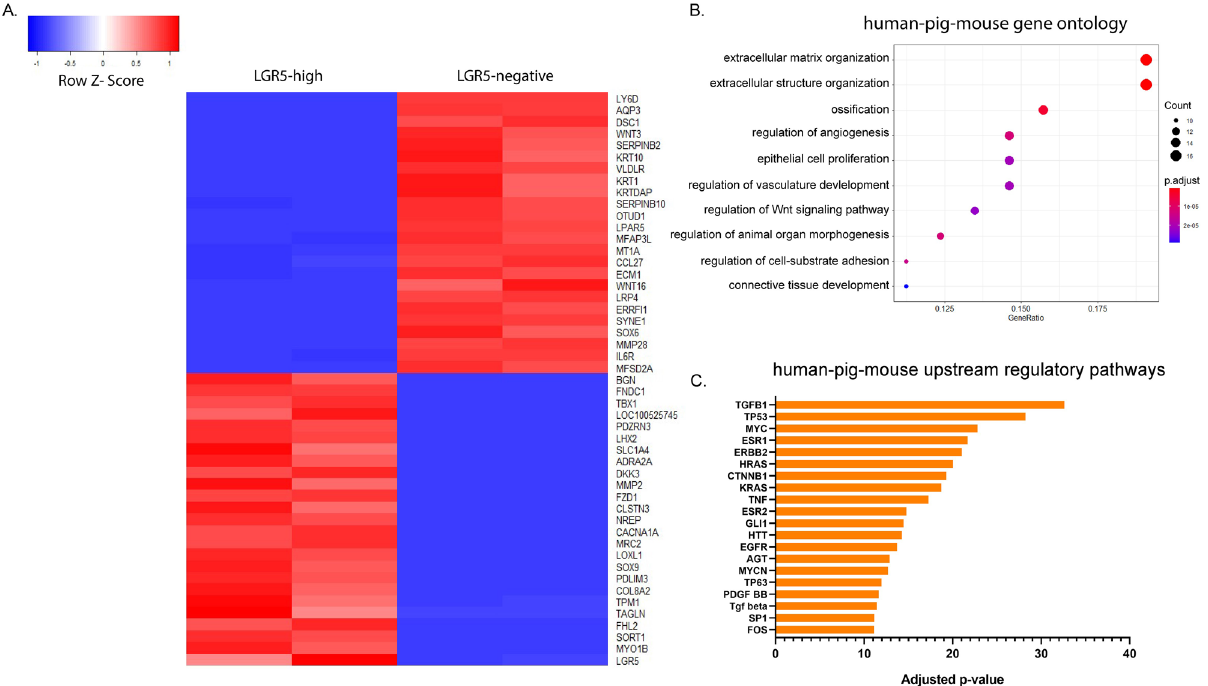
Figure 4. Gene ontology pathways in human, pig, and mouse LGR5-expressing epidermal populations are enriched in extracellular matrix structure and organization. ( A ) Top significantly upregulated (25) and downregulated (25) genes between LGR5-H2BGFP-high and LGR5-H2BGFP negative sorted pig samples. Bulk RNAseq samples were prepared from sorted populations from two pigs. Note confirmation of LGR5 and SOX9 upregulation in the LGR5-H2BGFP high population. ( B ) Comparison of all three species showing common gene ontology terms from genes that are upregulated in LGR5-high epidermis across all three species. ( C ) Upstream regulators that target a significant portion of the genes that are upregulated in LGR5 + cells from mice, human, and pig datasets. Each bar represents significance (negative log) of a set of multiple genes that impact a single regulatory